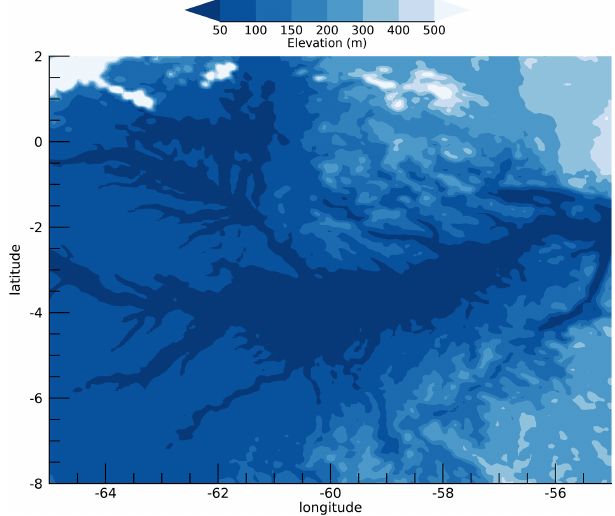
Figure 13. Terrain elevation for the large-scale to mesoscale analy- sis